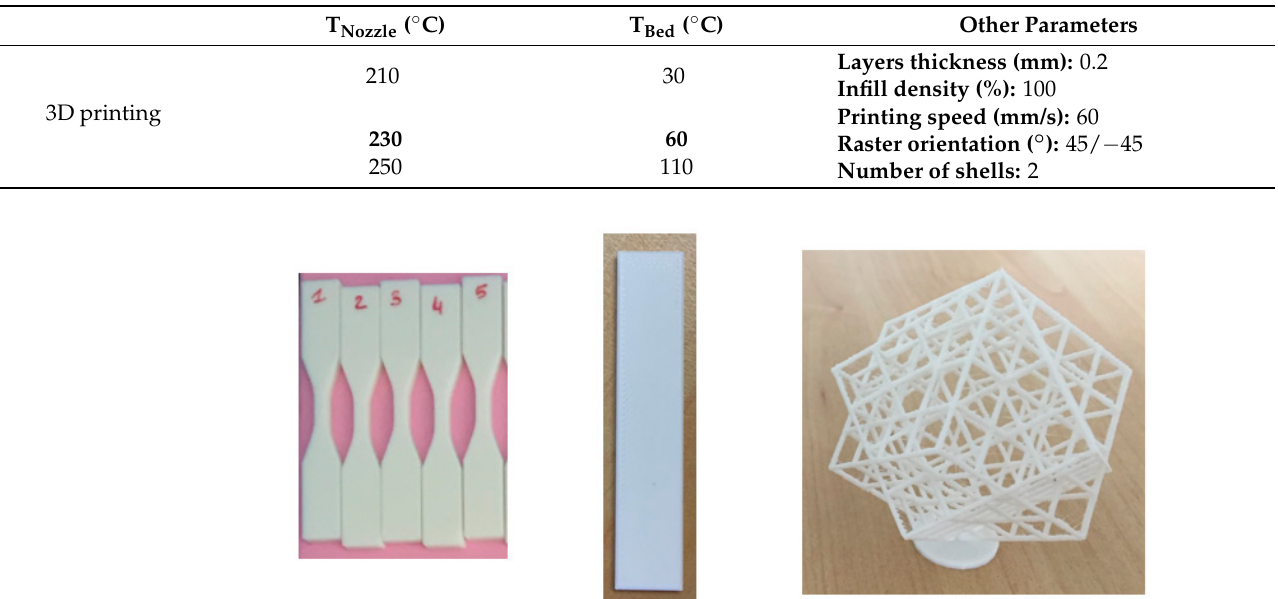
Table 2. Printing conditions of tensile and impact tests specimens.